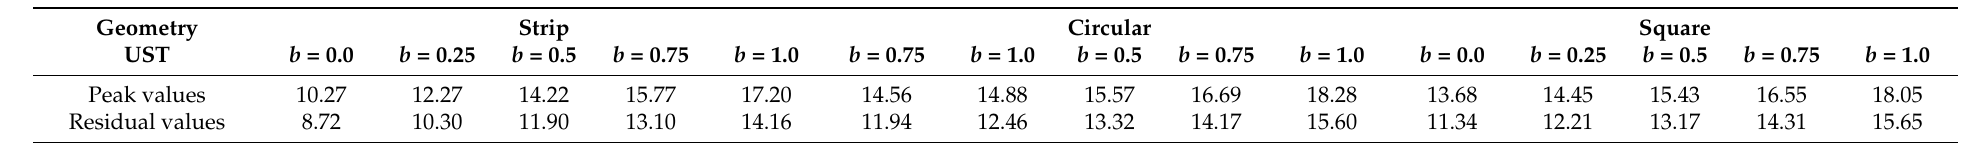
Table 2. Peak and residual values of bearing capacity factor N c yield by FLAC and UST.